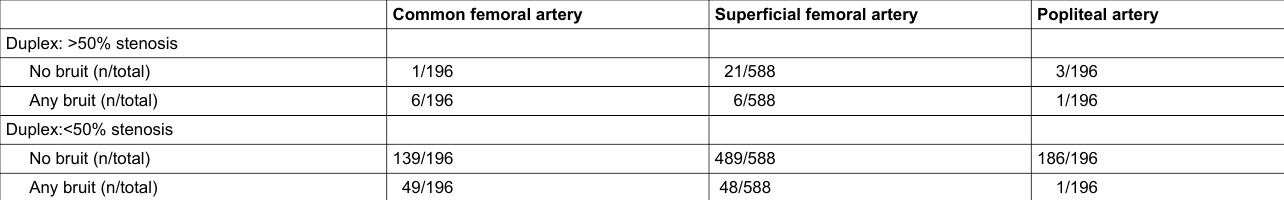
Table 5: Auscultation and duplex findings in different vascular regions: incidence of bruits in the three different vascular regions for investigator 1 compared with duplex findings (significant vs nonsignificant stenosis). Common femoral artery Superficial femoral artery Popliteal